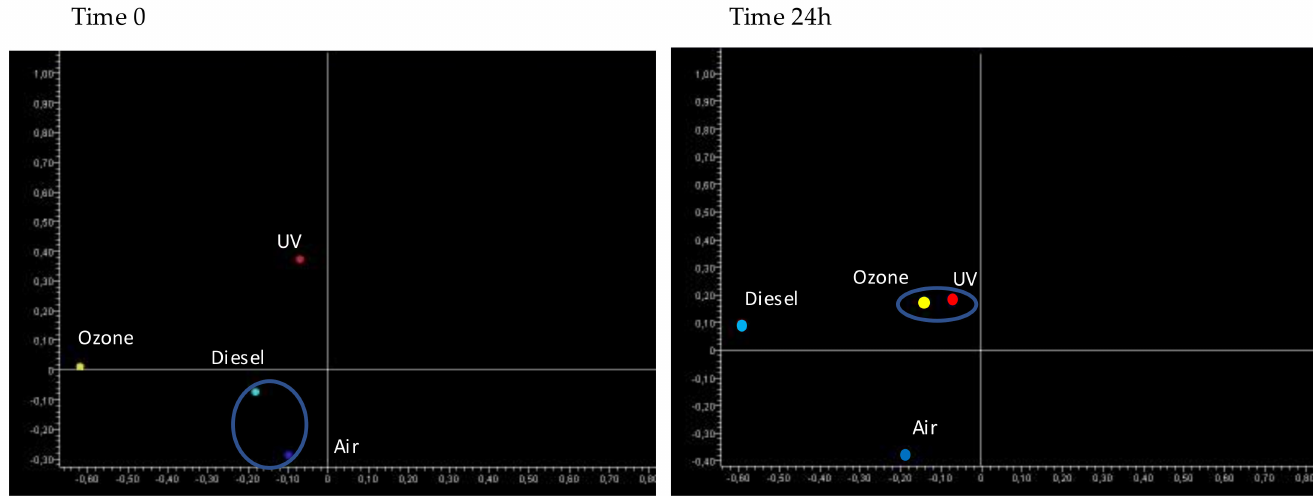
Figure 3. Bidimensional principal component analysis (PCA) of miRNA profiles of skin samples either untreated (air) or treated with diesel, ozone, and UV at 0 ( left panel ) and 24 h ( right panel ). PCA1 (X axis), PCA2 (Y